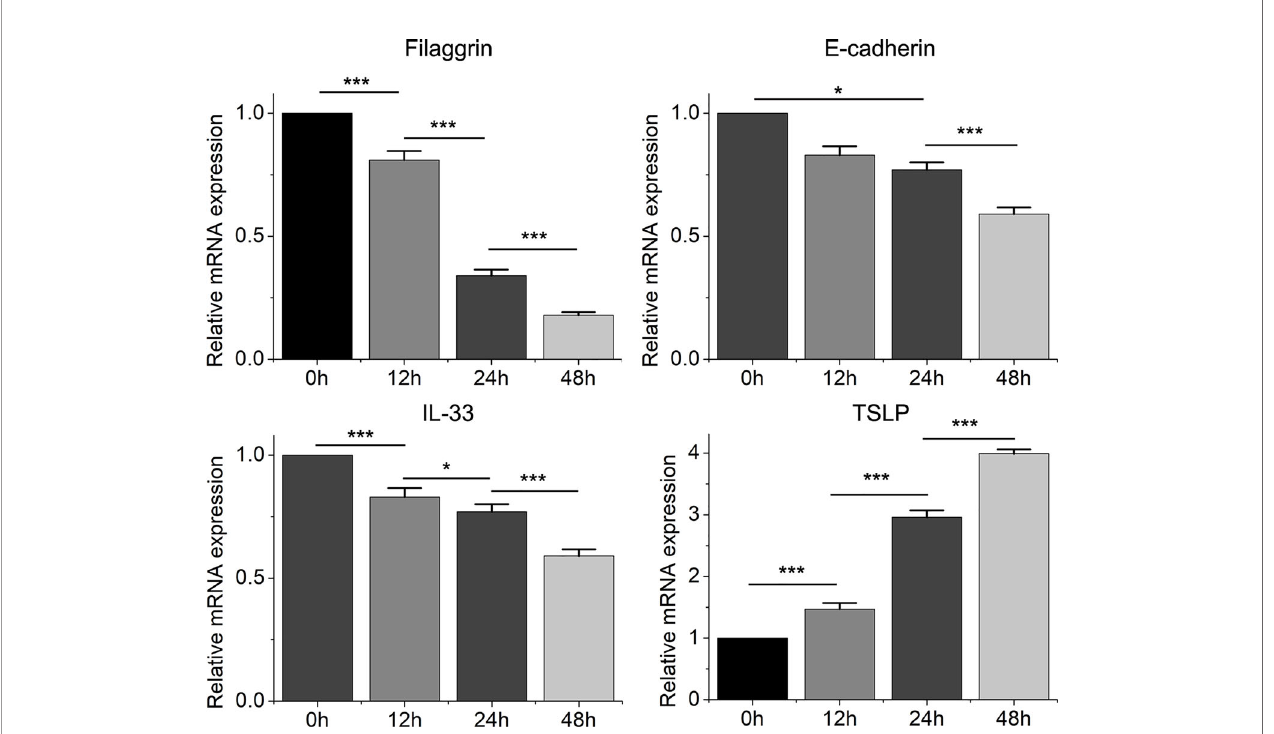
FIGURE 3 | The mRNA expression of fi laggrin, E-cadherin, IL-33 and TSLP in BEAS-2B cells with IL-4 treatment for different periods. Quantitative data are presented as the mean ± standard deviation (n=3). The Student ’ s t-test was used to analyze the difference between groups. *P < 0.05 was considered as statistically signi fi cant. ***P <